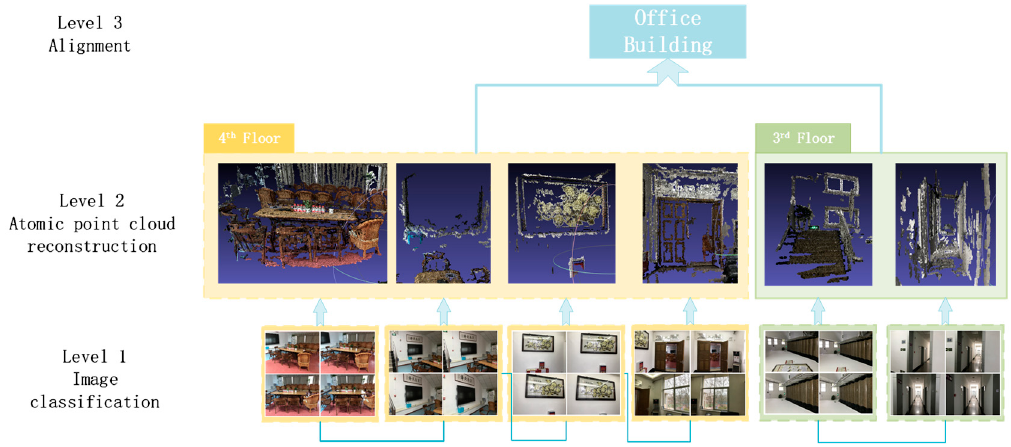
Figure 1. The workflow of the proposed annotated hierarchical SfM approach.